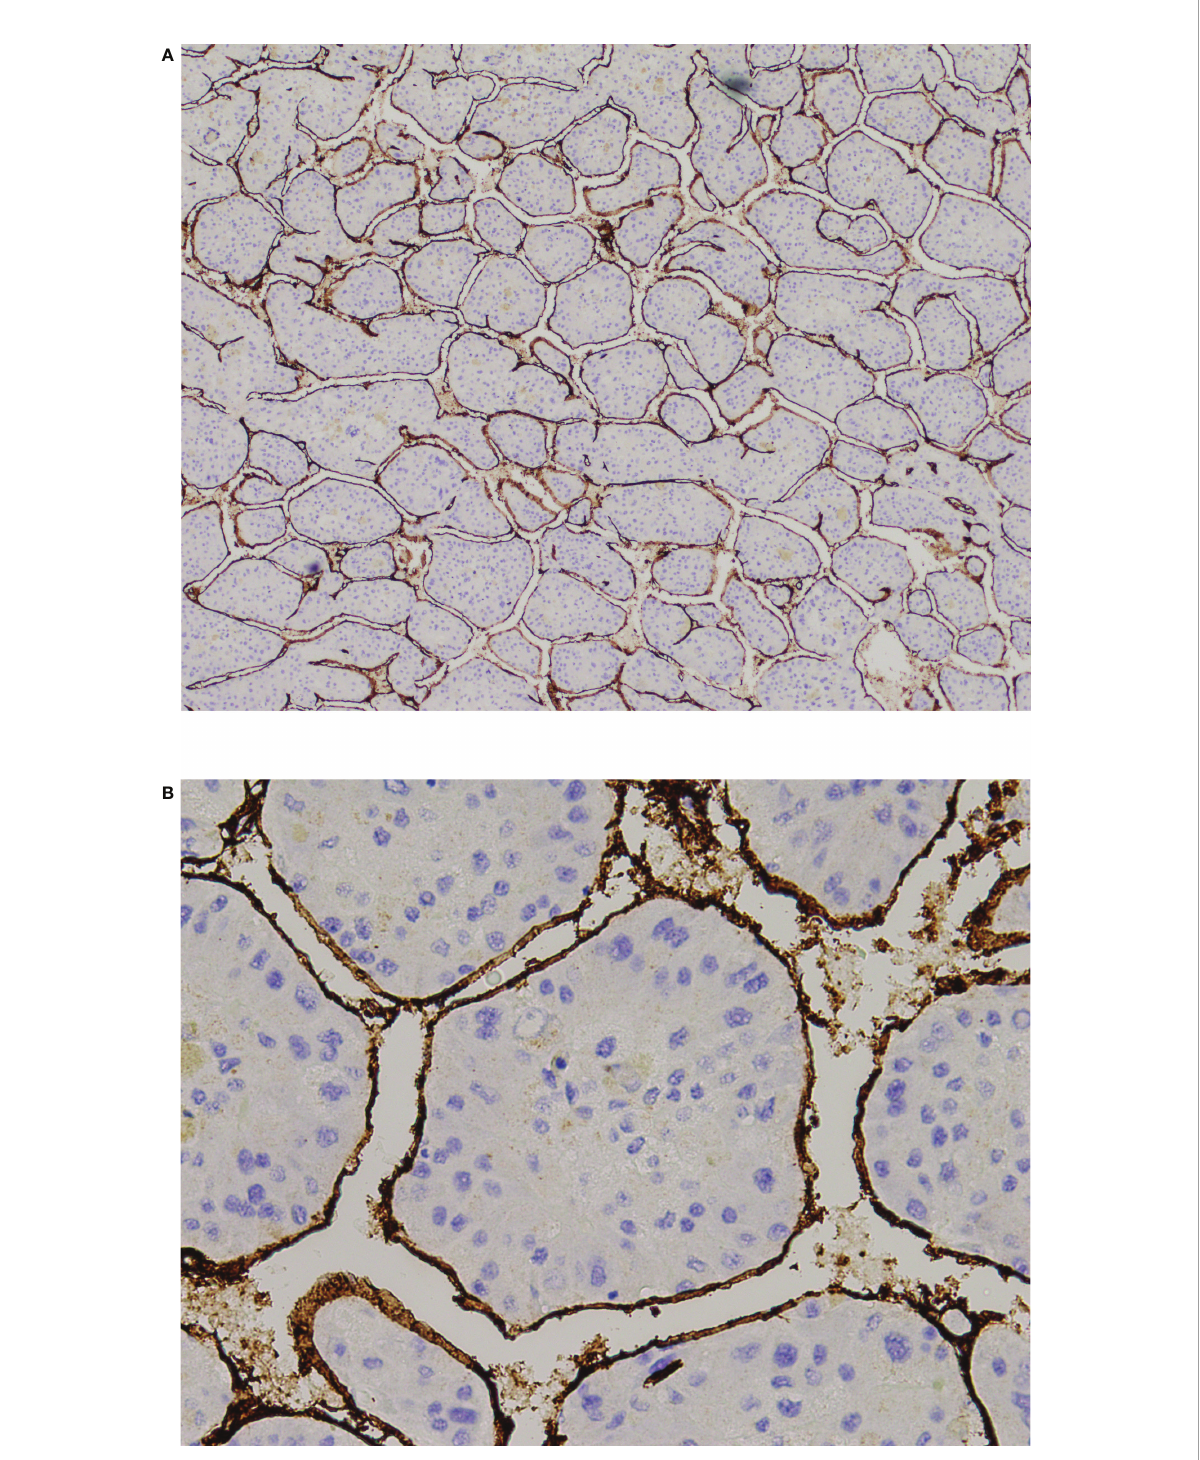
FIGURE 2 VETC-positive HCC. (A) 40X and and (B) 200X view of tumor clusters entirely encapsulated by endothelial cells. HCC, hepatocellular carcinoma; VETC, vessels that encapsulate tumor